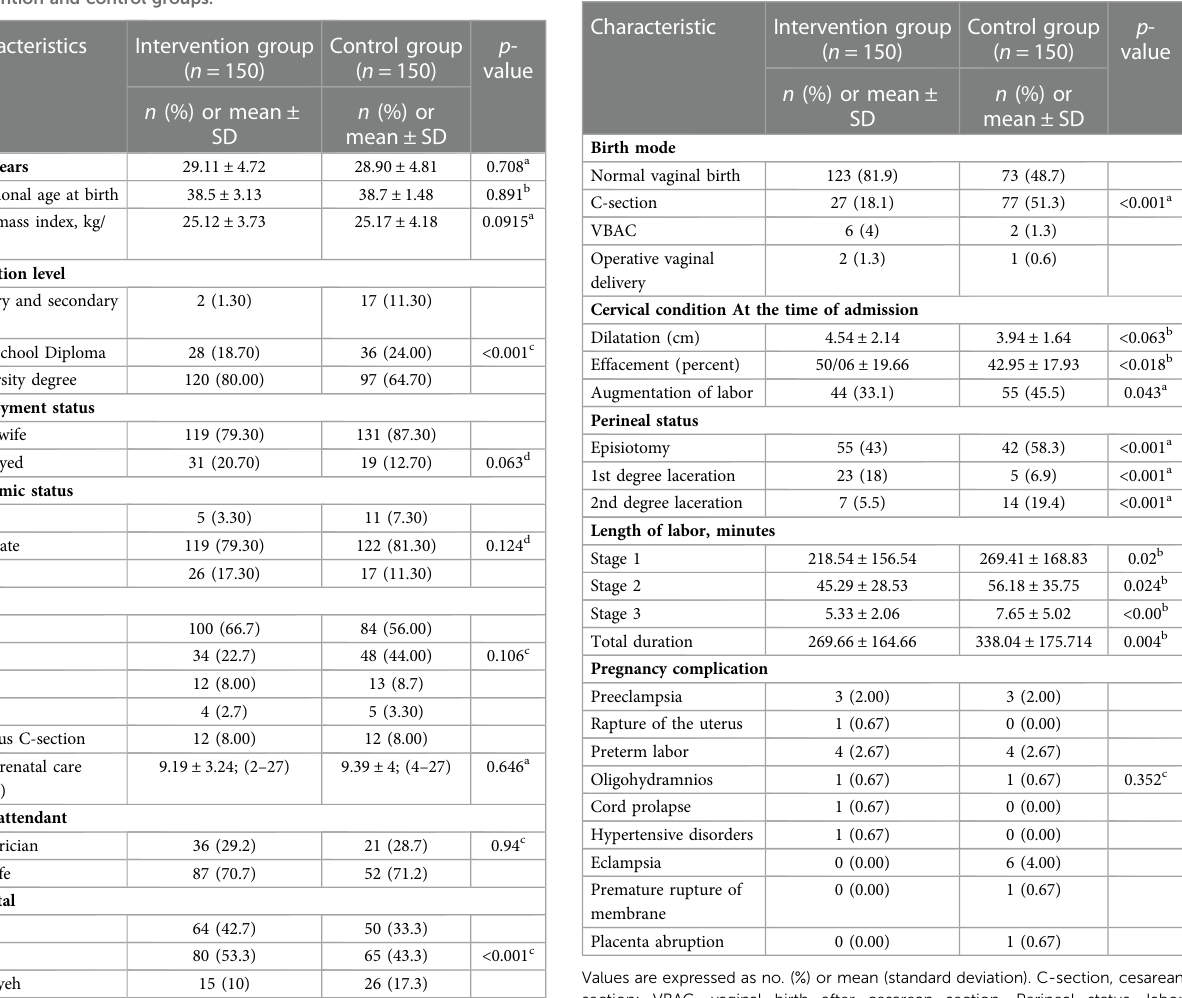
TABLE 2 Maternal outcomes in intervention and control